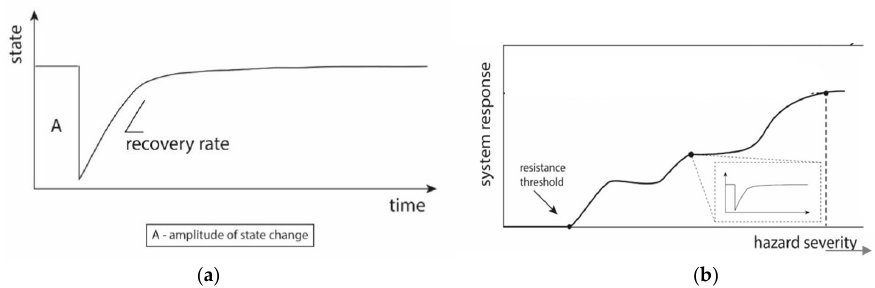
Figure 2. System response to a single shock ( a ) and as a function of disturbance magnitude (hazard severity) ( b ) (adapted from [19]).